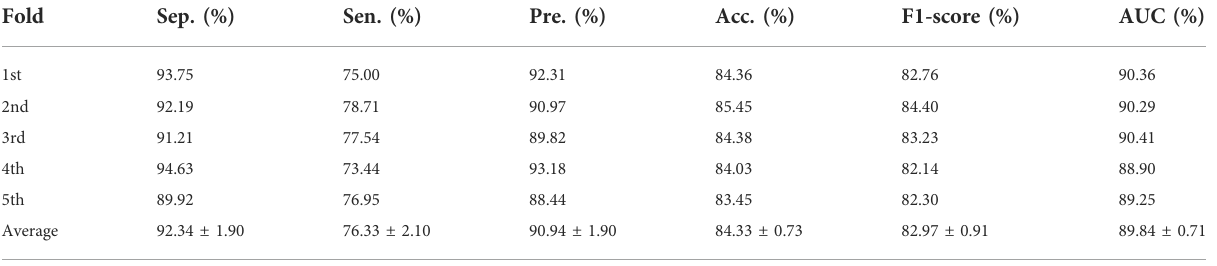
TABLE 3 Sep., Sen., Pre., Acc., and F1-score values achieved by SPCMLMI on the lncRNASNP dataset. Fold